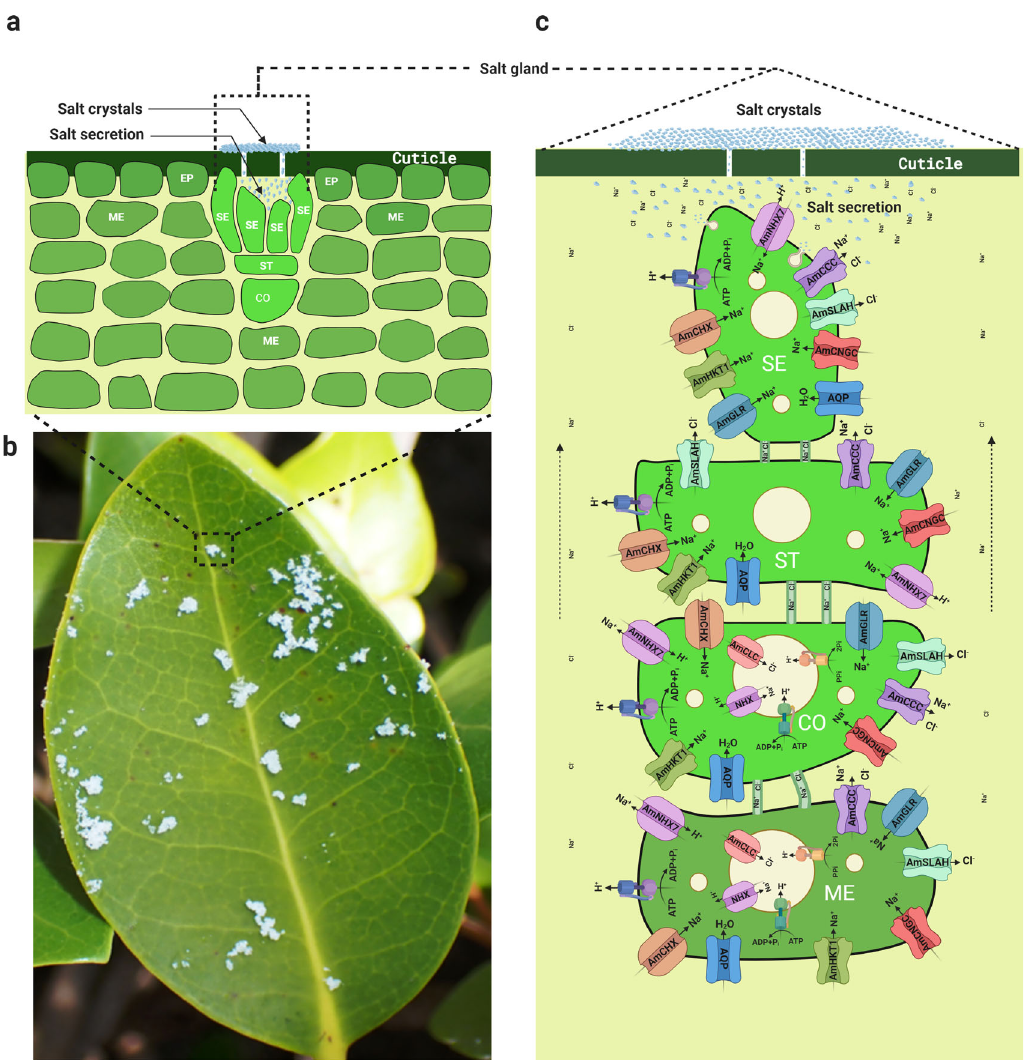
Fig. 1 Secretion of salts through the salt glands of Avicennia . a Schematic of a salt gland showing the mesophyll cells (ME), collecting cells (CO), stalk cell (ST), secreting cells (SE), and epidermal cells (EP). b Salts secreted by the salt glands and crystalized on the leaf surface. c Hypothetical mechanism of salt secretion through the salt glands involving ion channels, aquaporins, plasmodesmata, and vesicles. NHX sodium/hydrogen exchanger, CHX cation:proton antiporters, CCC cation-chloride cotransporter, SLAH slow anion channel-associated homologs, CNGC cyclic nucleotide-gated cation channel, GLR glutamate-activated channels, AQP aquaporin, CLC chloride channel, HKT1 high-af fi nity K + transporter